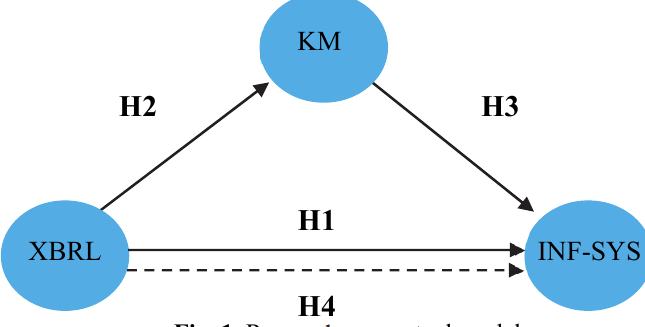
Fig. 1. Research conceptual